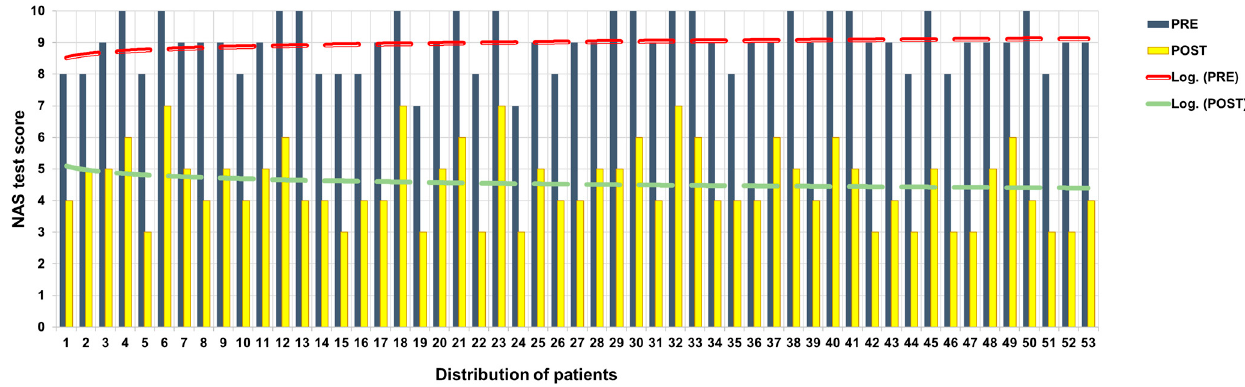
Figure 2. NAS score before and after ANM